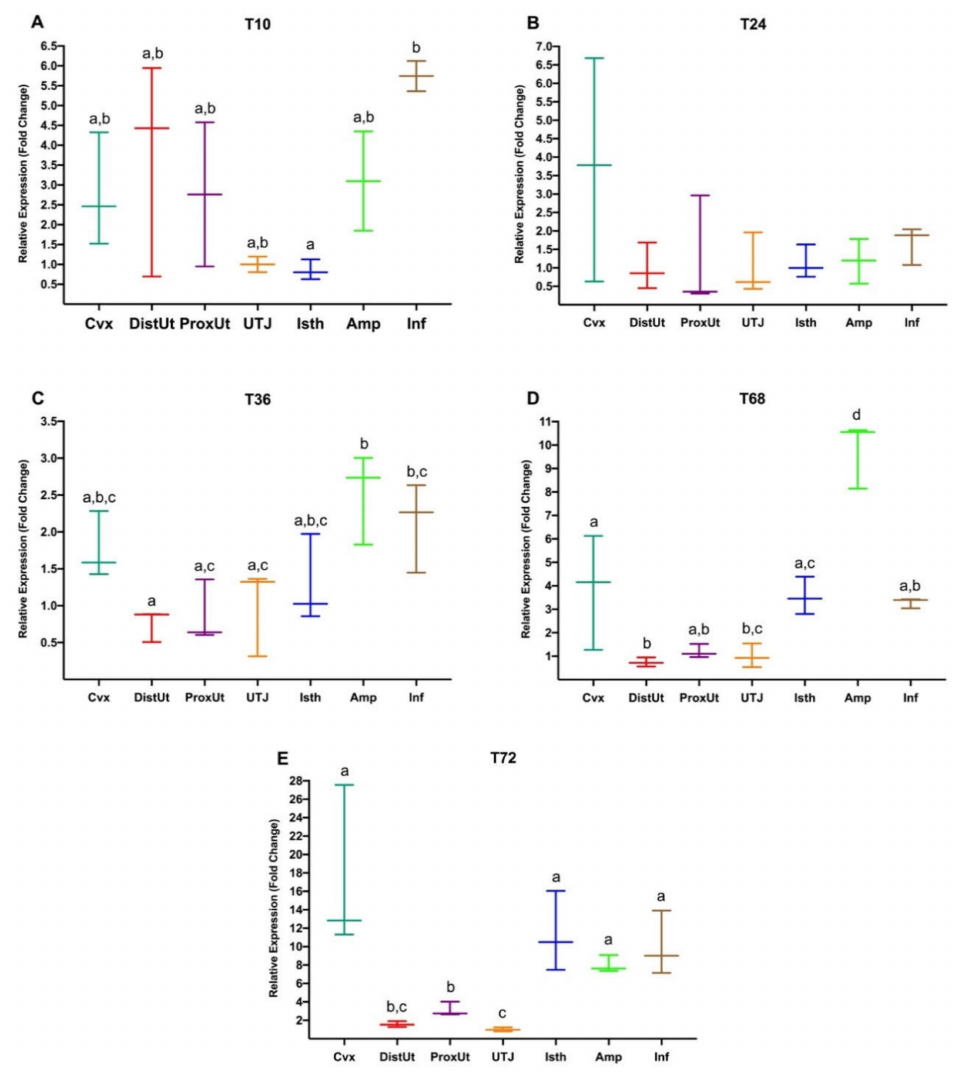
Figure 4. ( A – E ). NR3C1 gene expression di ff erences between anatomical segments (cervix, Cvx; distal uterus, DistUt; proximal uterus, ProxUt; utero-tubal junction, UTJ; distal isthmus, Isth; ampulla, Amp; infundibulum, Inf) in each of the timepoints 10 h ( A , T10), 24 h ( B , T24), 36 h ( C , T36), 68 h ( D , T68), and 72 h ( E , T72) post-mating. Di ff erent letters in the same timepoint indicate values that di ff ered significantly between anatomical regions ( p < 0.05). The expression was relativized using the UTJ as a reference. Median [minimum,